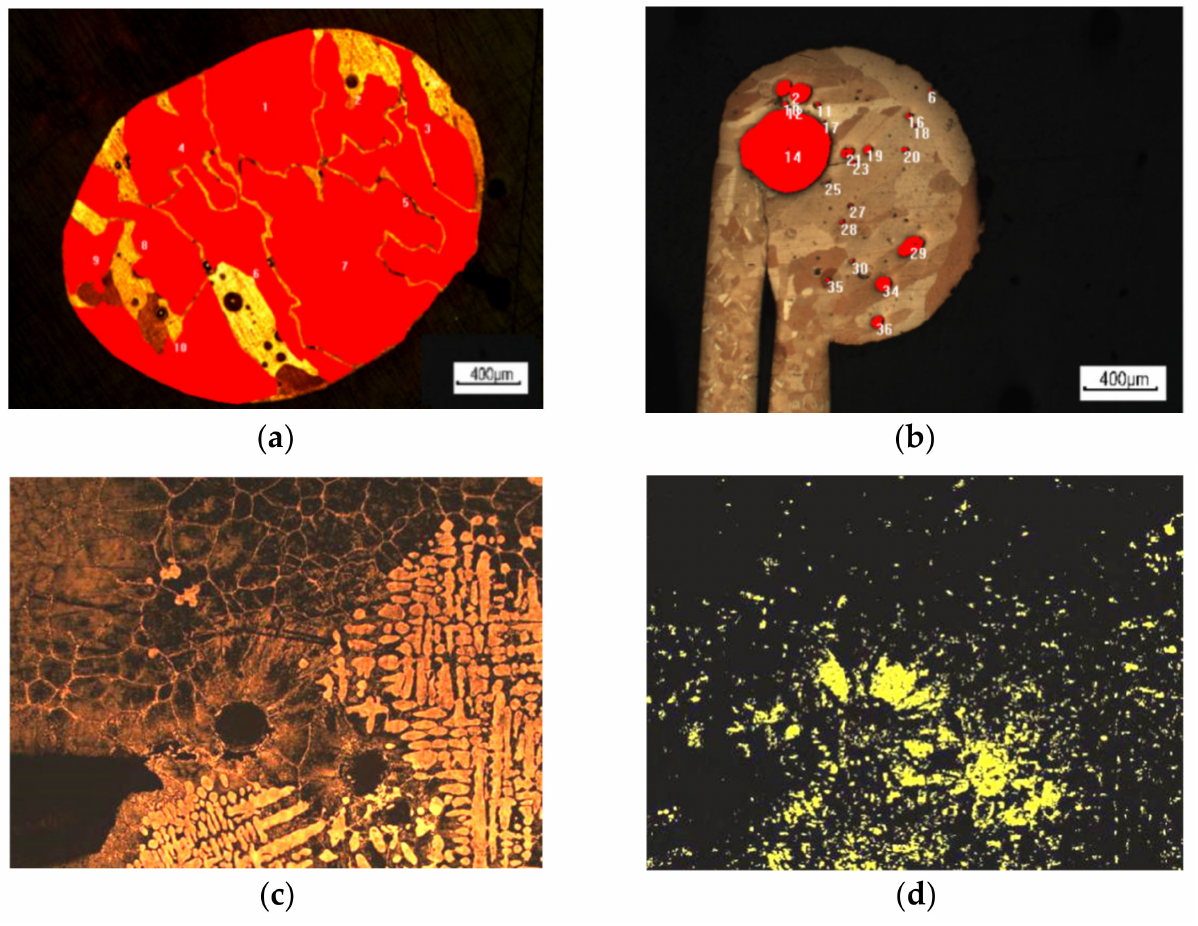
Figure 2. Examples of metallurgical microstructural parameters extraction and measurement by IPP 6.0. Micrographs shown in ( a – d ) are views of grains selected by IPP, porosities selected by IPP, a bright-field of metallurgical structure, and a polarized-field after a binary